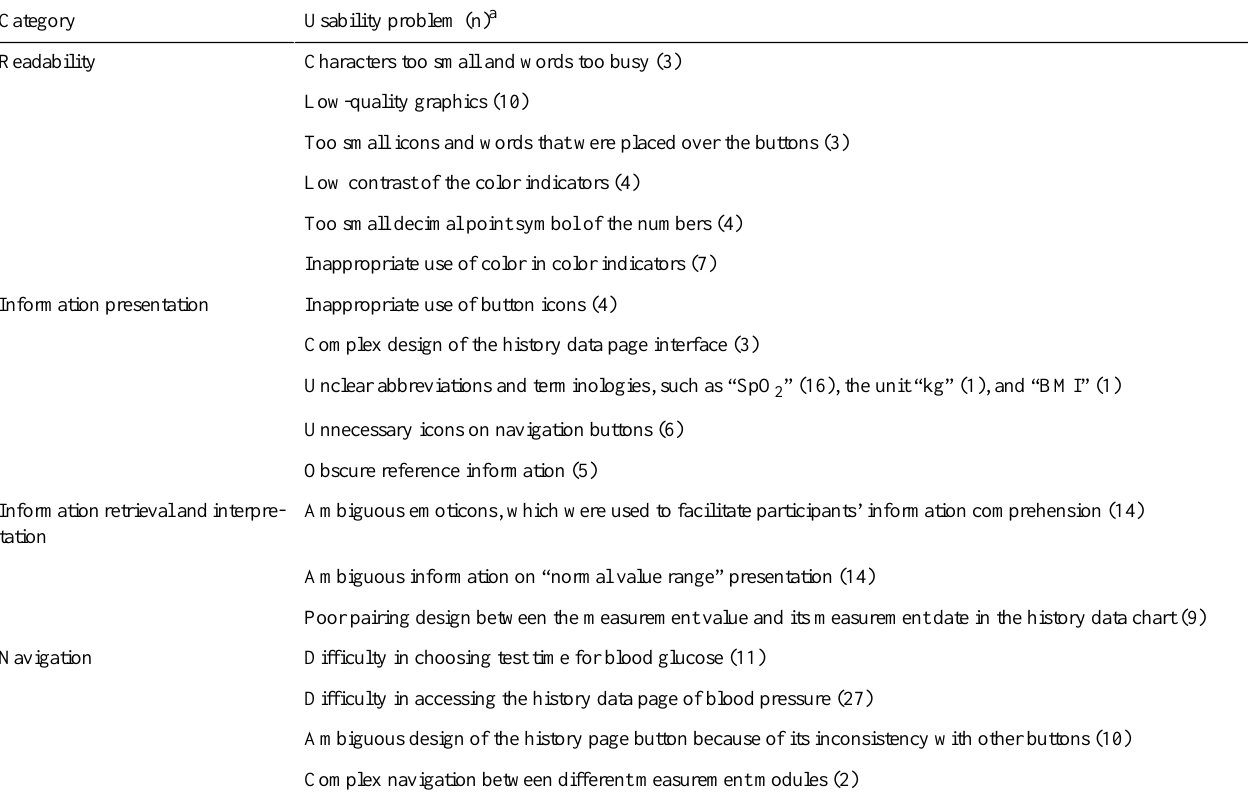
Table 8. Usability problems identified from the open-ended